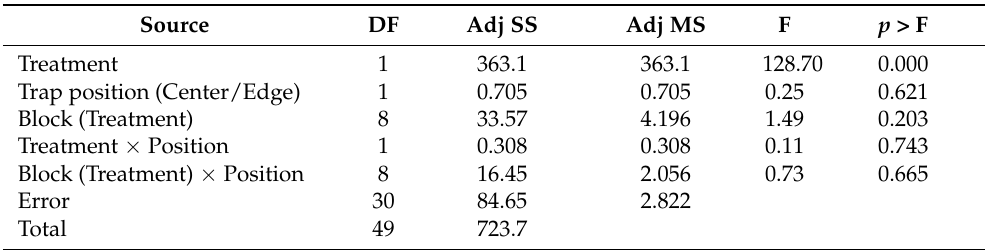
(Figure 6a; R 2 = 0.74; F = 21.29, df = 1,8, p = 0.002; test of residual normality: AD = 0.313, n = 10, p = 0.49).